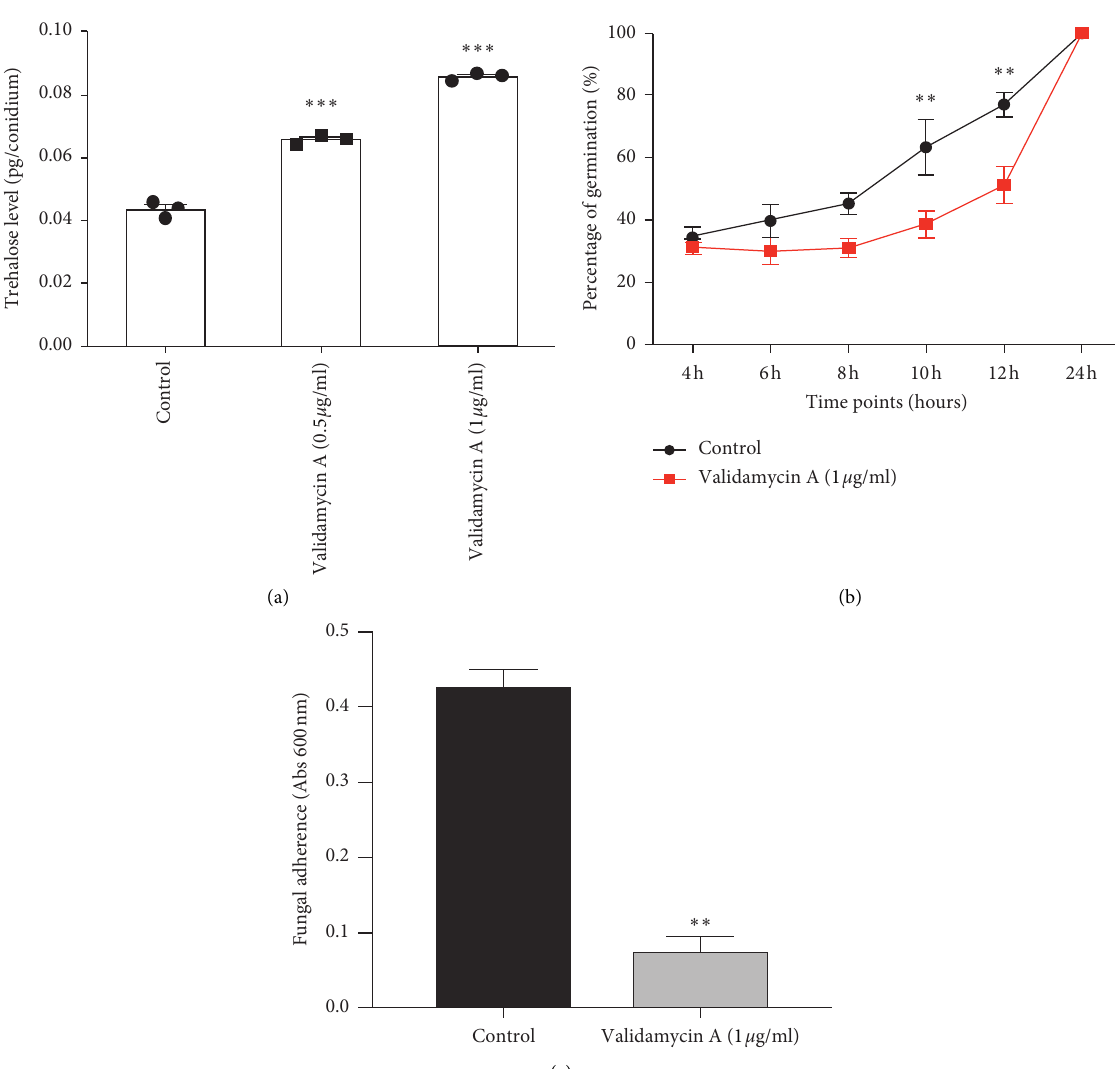
Figure 4: Validamycin A increases trehalose levels in Aspergillus flavus conidia with delayed conidial germination and decreased fungal adherence. (a) Aspergillus flavus ATCC 204304 was cultured at 37 ° C on Sabouraud dextrose agar for five days with or without 1 μ g/mL validamycin A. Trehalose assays were performed to measure trehalose levels in the conidia using glucose oxidase assays. Data are presented as means ± SE from three biological replicates. ∗∗∗ P value < 0.001 (unpaired two-tailed Student’s t -test compared with the control). (b) Aspergillus flavus ATCC 204304 was cultured at 37 ° C in Sabouraud dextrose broth with or without 1 μ g/mL validamycin A in an orbital shaker at 200rpm. Conidial germination at each time point was counted and calculated. Data are presented as means ± SE from three biological replicates. ∗∗ P value < 0.01 (unpaired two-tailed Student’s t -test compared with the control). (c) Aspergillus flavus ATCC 204304 was cultured at 37 ° C in Sabouraud dextrose broth with or without 1 μ g/mL validamycin A in 96-well plates for 24 hours, and crystal violet adherence assays were performed. Data are presented as means ± SE from three biological replicates. ∗∗ P value < 0.01 (unpaired two-tailed Student’s t -test compared with the